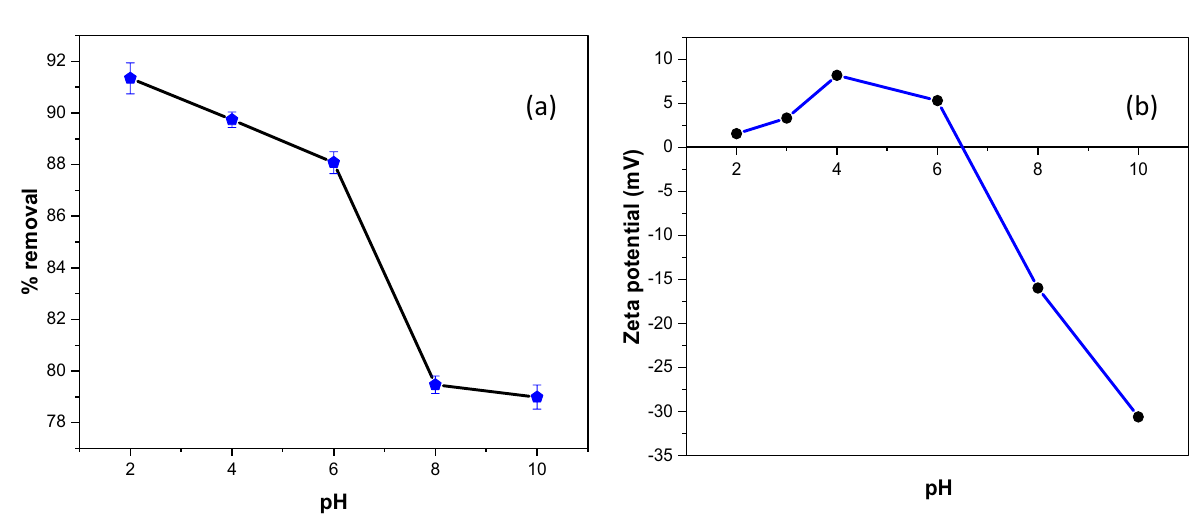
Figure 9. ( a ) Influence of pH on adsorptive CR removal using GSC WCO , ( b ) zeta potential of GSC WCO at different pH